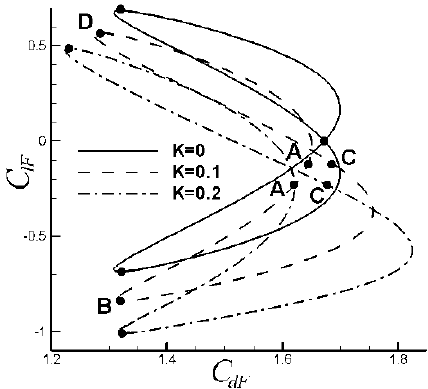
Figure 5. The variation of C ∼ C dF lF phase diagram with shear rate K .